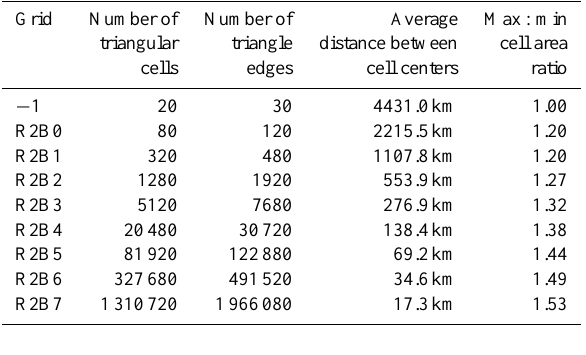
Table 1. Total number of triangle cells and edges in various grids with root division n r = 2, the average distance between neighboring cells, and the area ratio of largest to smallest triangles. Grid − 1 is the icosahedron projected onto the sphere.